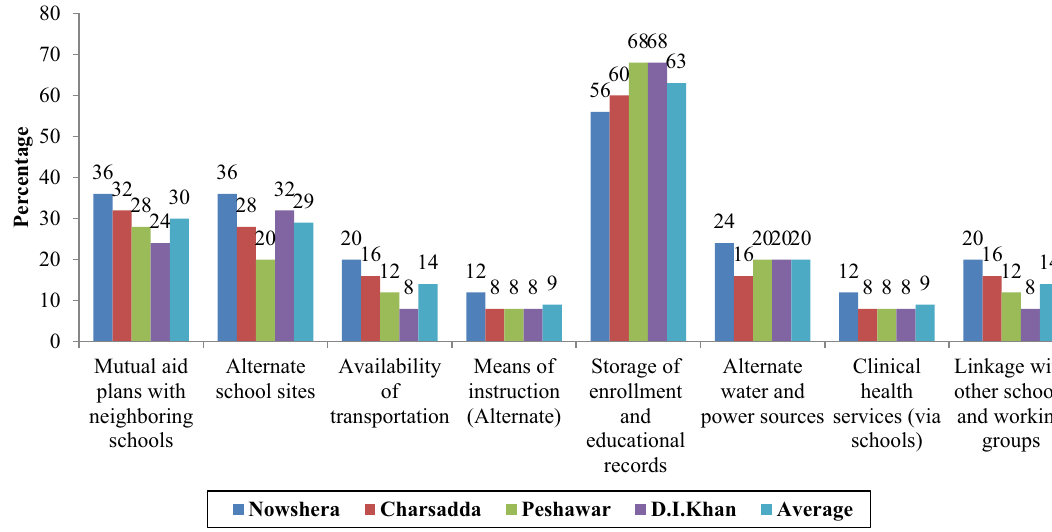
Fig. 6 Khyber Pakhtunkhwa’s school planning for continuation of teaching after a disaster,